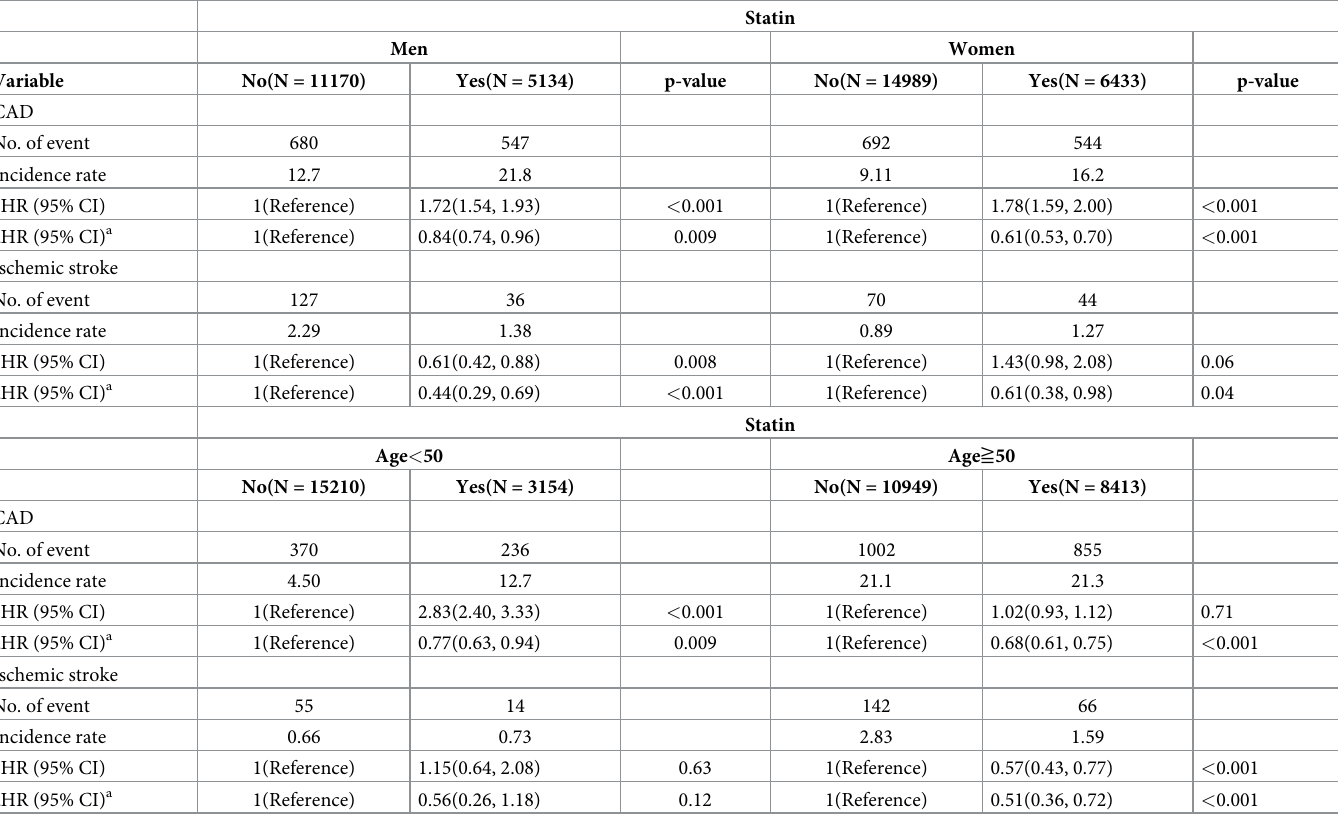
Table 3. Overall Incidence (per 1,000 person-years) and hazard ratio for coronary artery disease and ischemic stroke in interstitial lung disease patients and pulmo- nary fibrosis with statin compared to the interstitial lung disease and pulmonary fibrosis patients without statin stratify by gender and age by time dependent regression